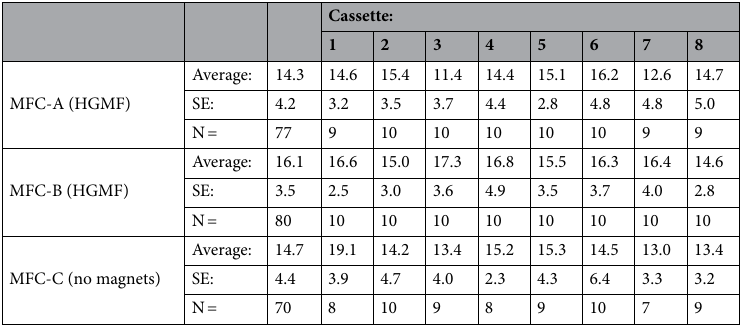
Table 1. Germination and root length of Brassica rapa seeds in magnetic field chambers with (A&B) and without magnets (C). There was no difference between chambers or seed cassettes.